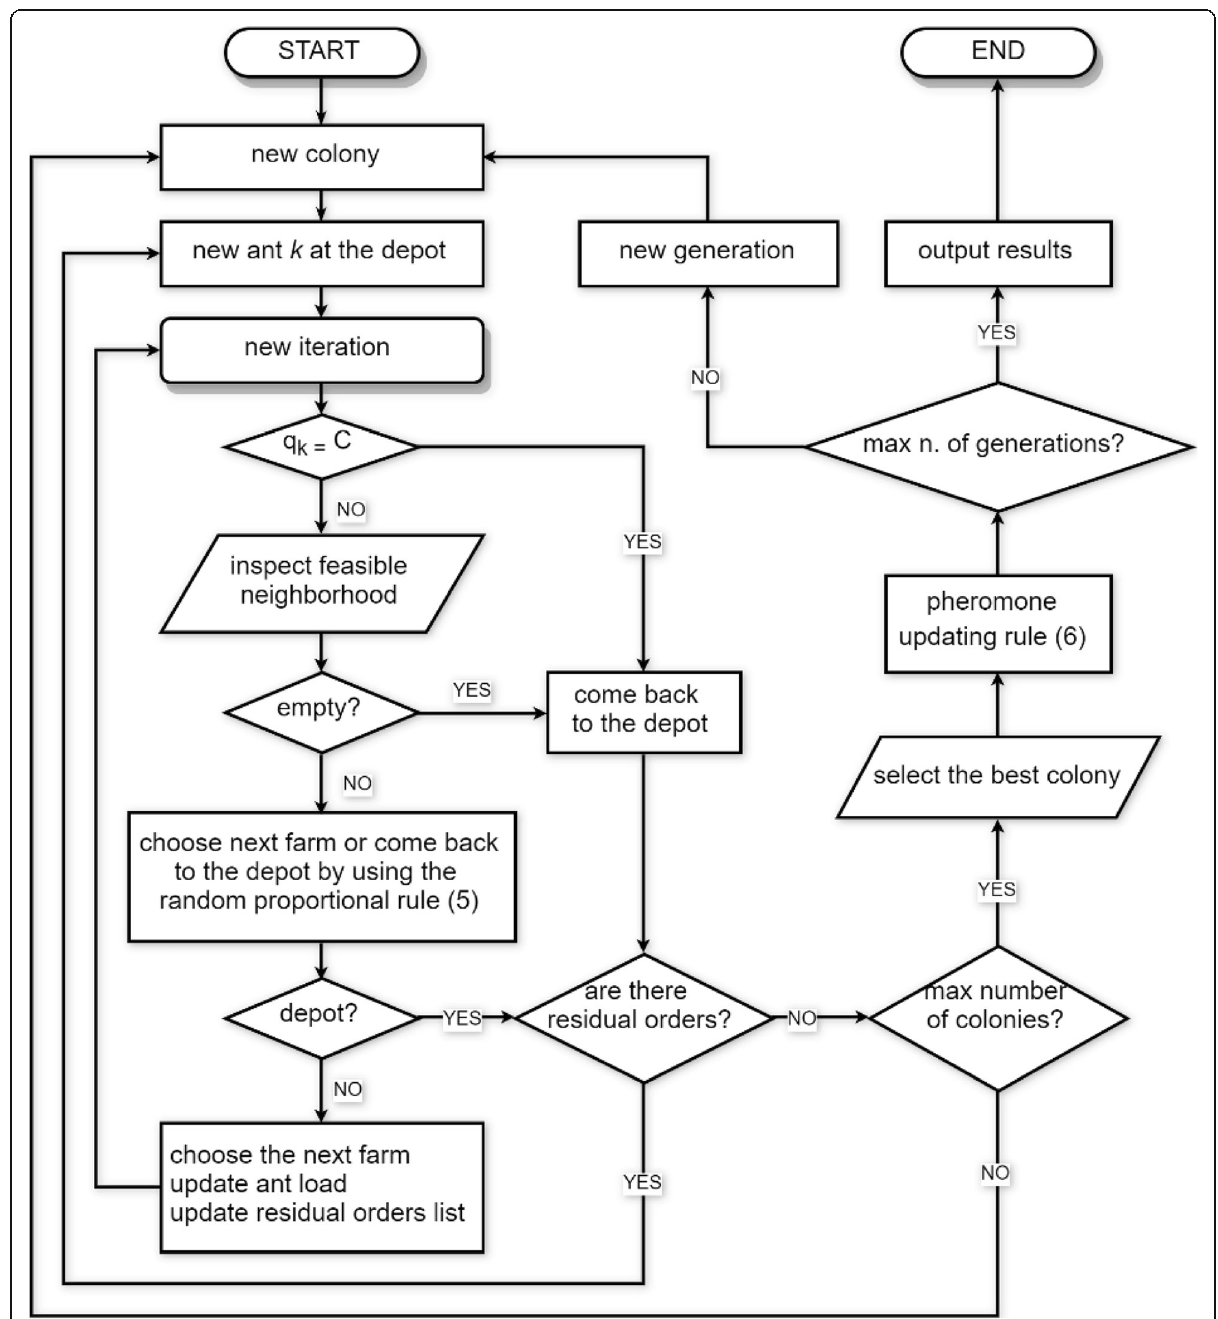
Fig. 2 Flow chart of the ACO